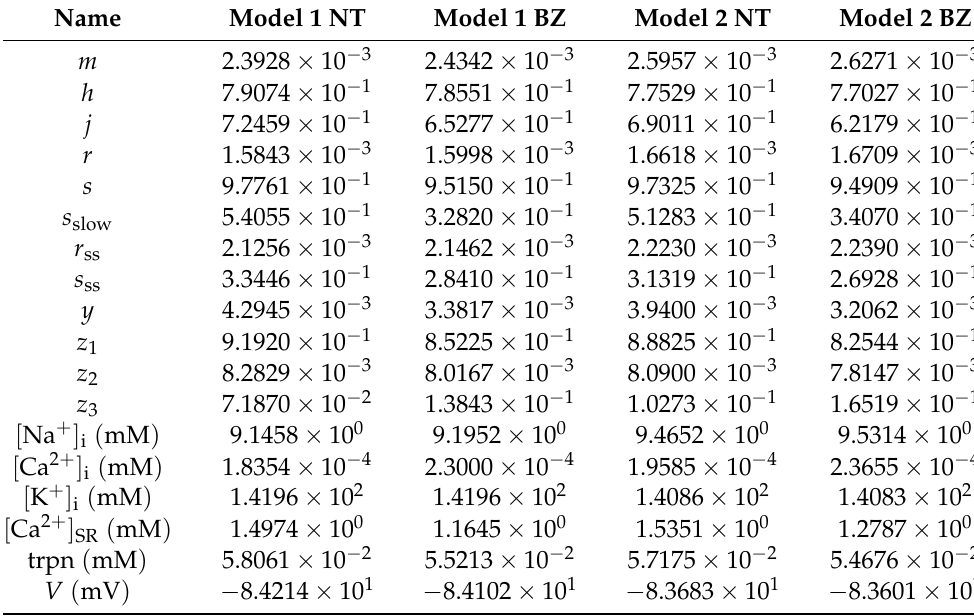
Figure A6. Electrical activity at a point at the base of the heart during rotation of a wave in Model 2 shown in Figure 9, bottom rows, Video 3D_2_around_scar. The measurements were taken in the middle of the region where the white spot appears at 390 ms (Figure 9, bottom row second column). Prolonged action potential attributed to EAD is marked by an arrow. Table A2. Steady state initial conditions at 170 ms BCL for Models 1 and